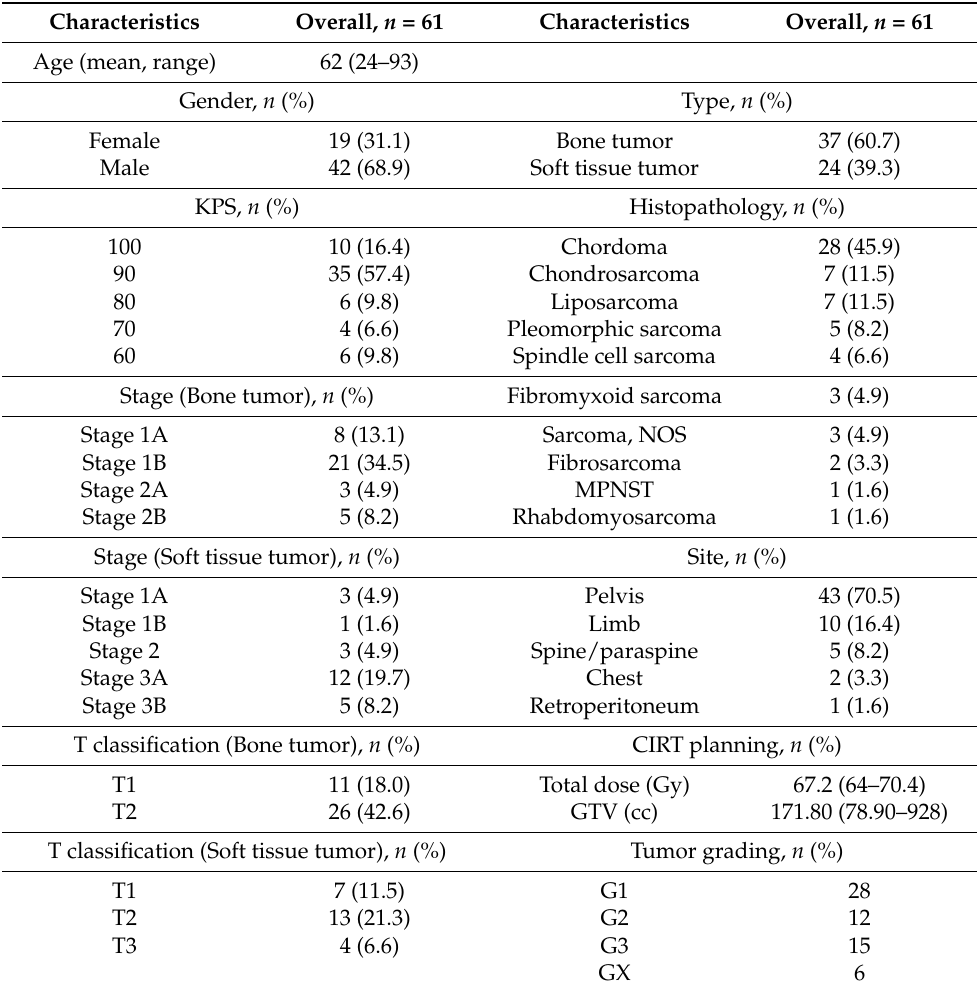
Table 1. Patient